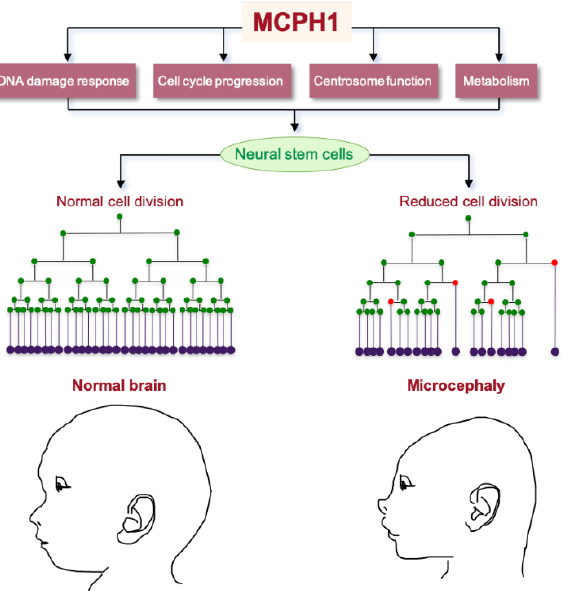
Figure 1. MCPH1 regulates brain size. MCPH1 is employed in many cellular functions that regulate the division mode of neural stem cells during embryonic brain development. Impairment of MCPH1 functions leads to an insufficient production of neurons (depicted in the diagram by dark purple dots) due to the premature differentiation of neural stem cells (depicted by red dots) and a reduction of self-renewal divisions (depicted by green dots). As a result, microcephaly manifests in affected